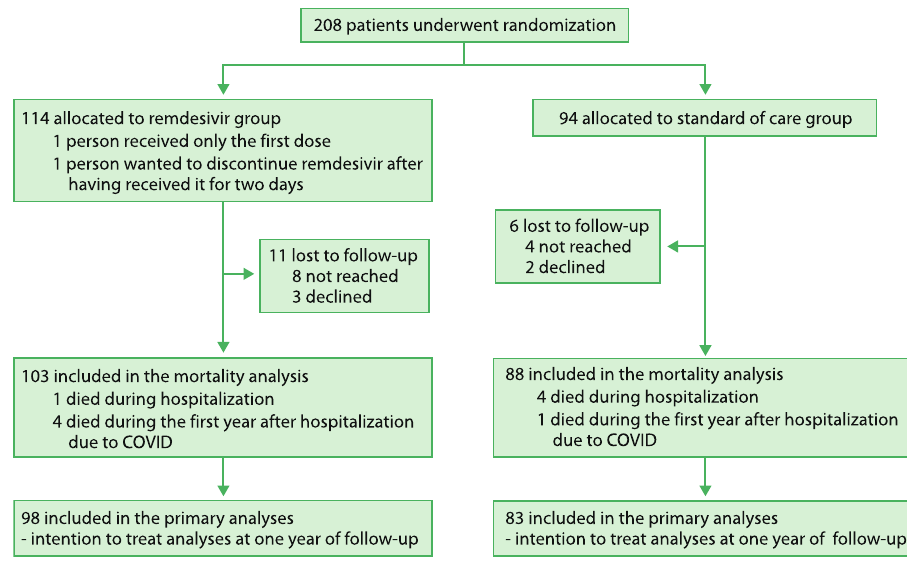
Fig. 1 | Study fl ow